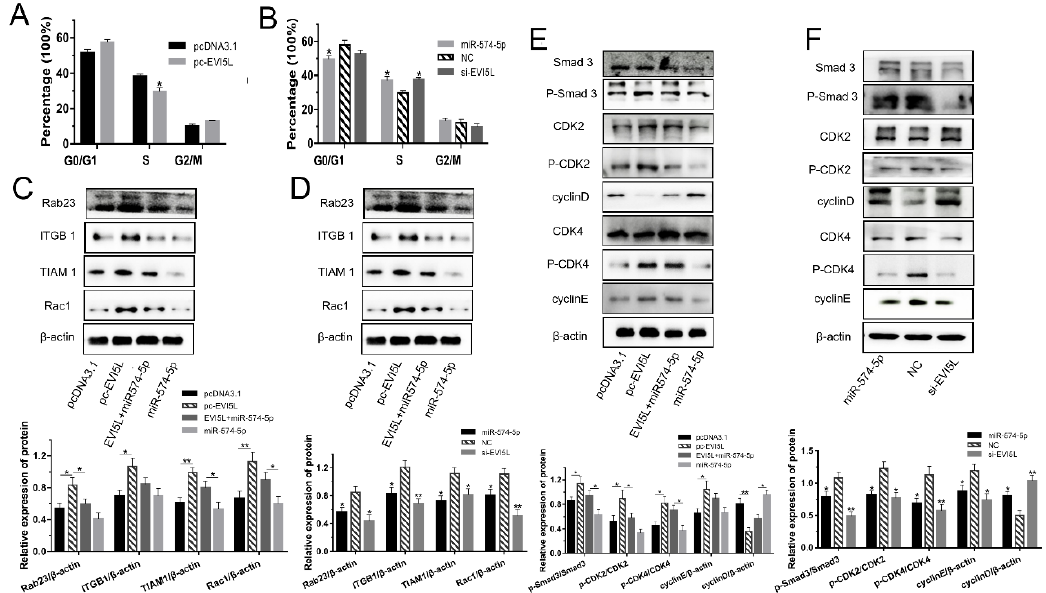
Figure 2. EVI5L caused the G0/G1 phase arrest and promoted the S phase in the GMECs. ( A ) Pc- EVI5L and pcDNA3.1 were transfected in GMECs and the cells were cultured for about 24 h before collection, then the cell cycle was examined by FCM. ( B ) FCM analyzed the cell cycle of the GMECs transfected with miR-574-5p, si- EVI5L , and NC. ( C , D ) EVI5L affected the protein expression of the Rab23/ITGB1/TIAM1/Rac1 pathway in the WB assay. ( E , F ) Western blot analysis used to assess the effect of EVI5L on the TGF-β/Smad pathway in GMECs. FCM: flow cytometry analysis; pc- EVI5L , overexpression EVI5L plasmid; pcDNA3.1: control group; NC: negative control; si- EVI5L : small interfering RNA of EVI5L; EVI5L + miR-574-5p: pcDNA3.1- EVI5L + miR-574-5p. ** means significant difference ( p < 0.01), * means significant difference ( p < 0.05).